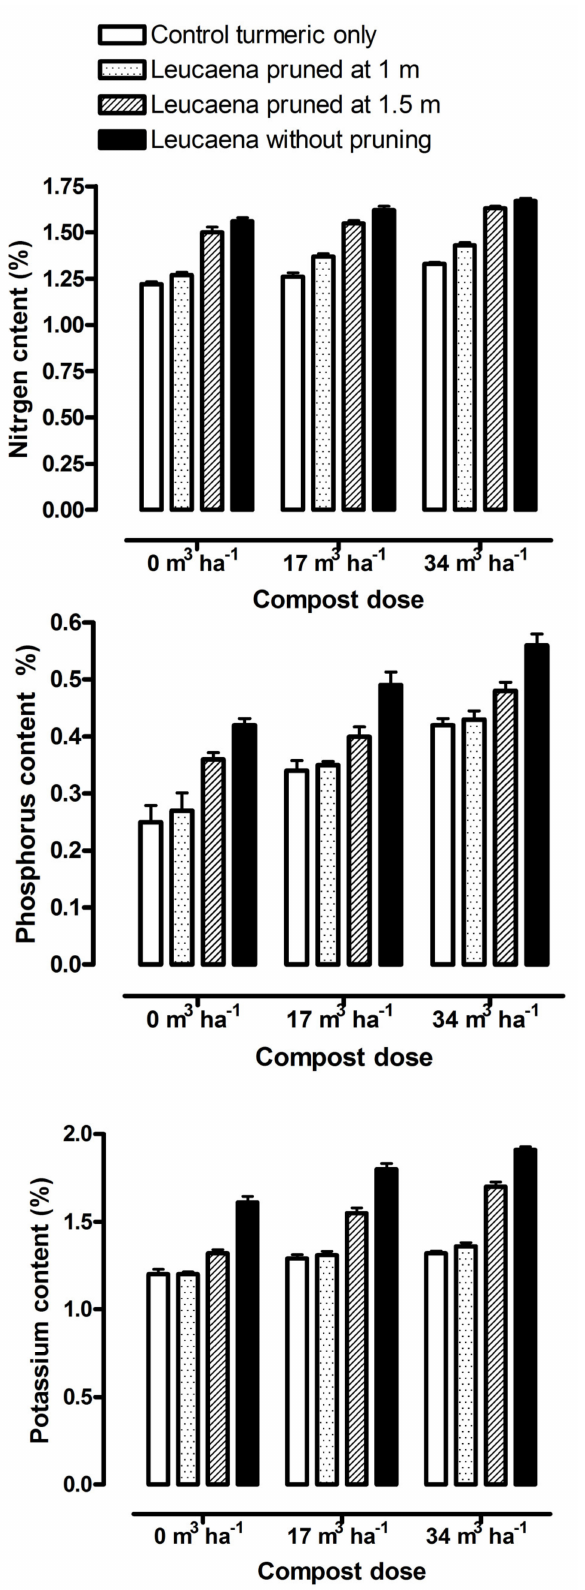
Figure 3. Nitrogen, phosphorus and potassium contents (%) in leaves of Curcuma longa in response to alley-cropping and organic-compost treatments as pooled data of the two seasons of 2021 and